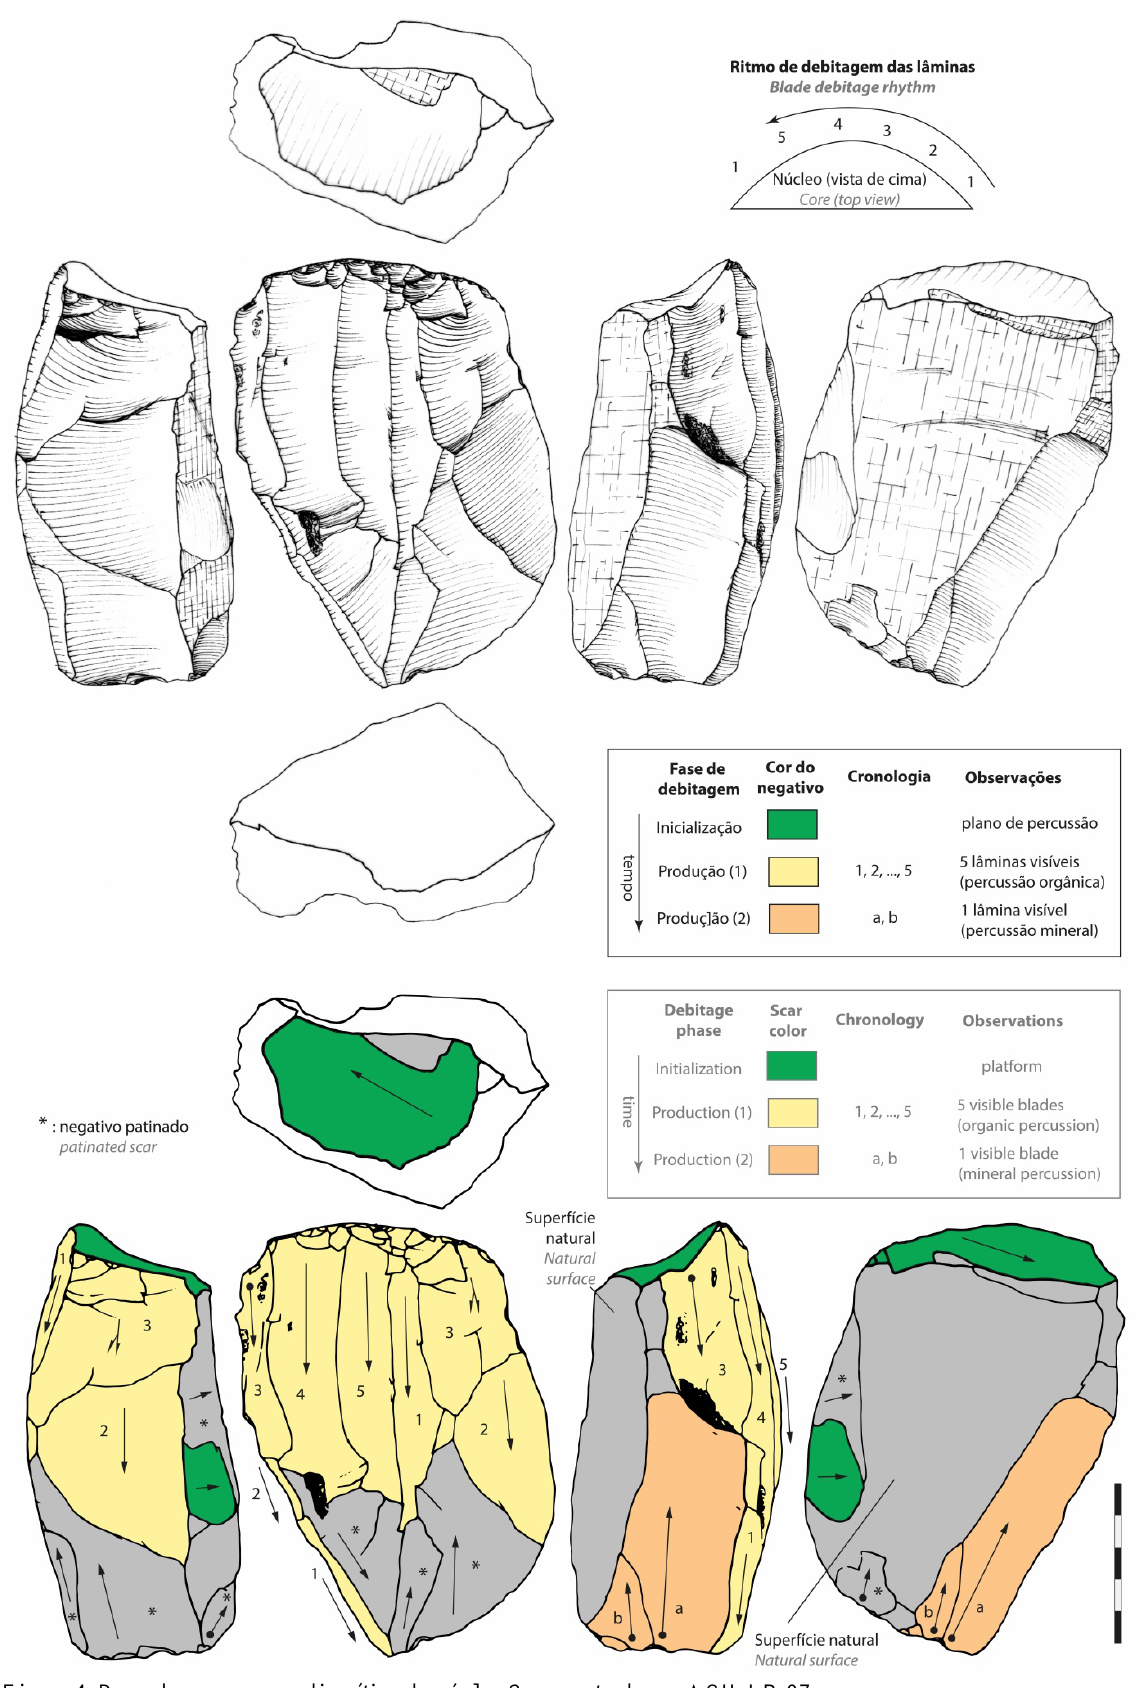
Figura 4. Desenho e esquema diacrítico do núcleo 2, encontrado em ACH-LP-07. Figure 4. Drawing and diacritic scheme of core 2, from